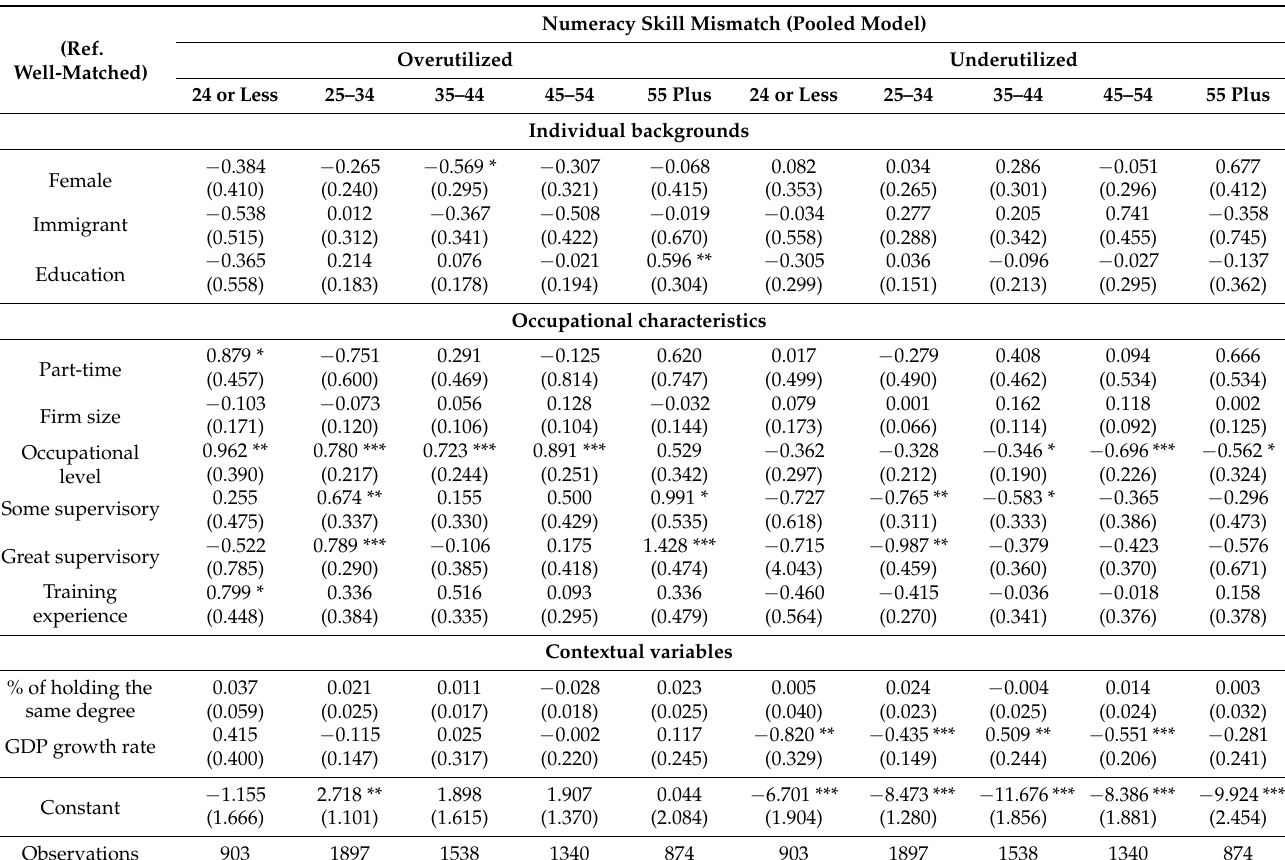
Table 9. Pooled model by age (numeracy